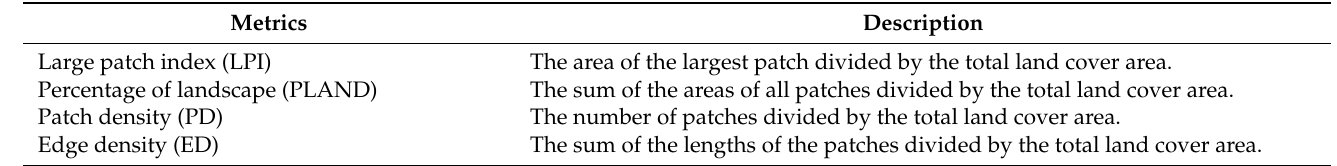
Table 2. Landscape metrics used to quantify land cover spatial patterns in this study. Metrics Description Large patch index (LPI) The area of the largest patch divided by the total land cover area. Percentage of landscape (PLAND) The sum of the areas of all patches divided by the total land cover area. Patch density (PD) The number of patches divided by the total land cover area. Edge density (ED) The sum of the lengths of the patches divided by the total land cover area. Four metrics for urban, agricultural, and forest land cover (patches) were calculated